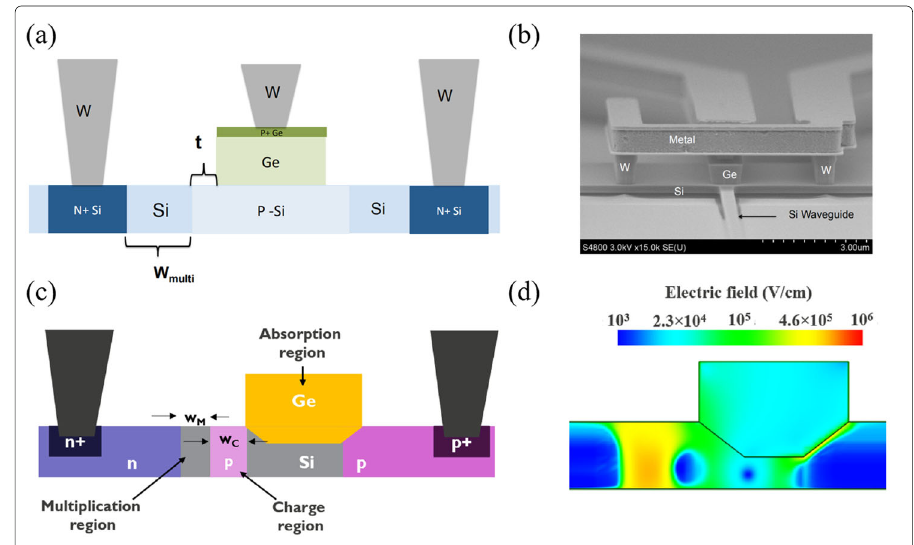
Fig. 9 a Schematic cross-section and b SEM image of the waveguide-coupled Si-Ge lateral SACM APD with p-contact on germanium [107]; c Schematic cross-section and d electric field distribution of the waveguide-coupled Si-Ge lateral SACM APD with contacts on silicon